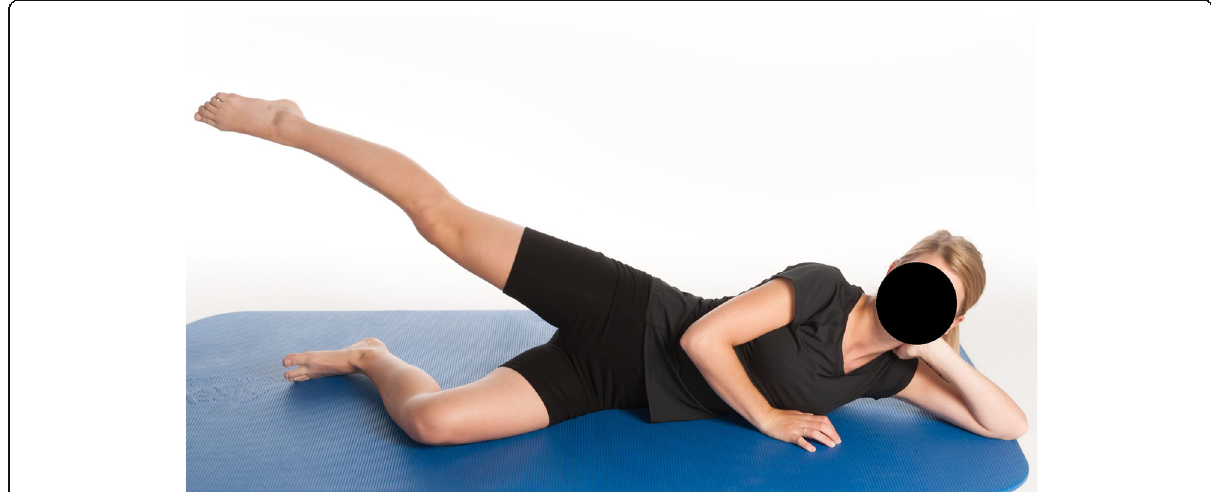
Fig. 1 Straight leg side raises. The exercise should be performed on the floor with the pelvis tilted forward and the upper leg behind the plane of the body. Lift the straight upper leg and slowly returned it to the starting